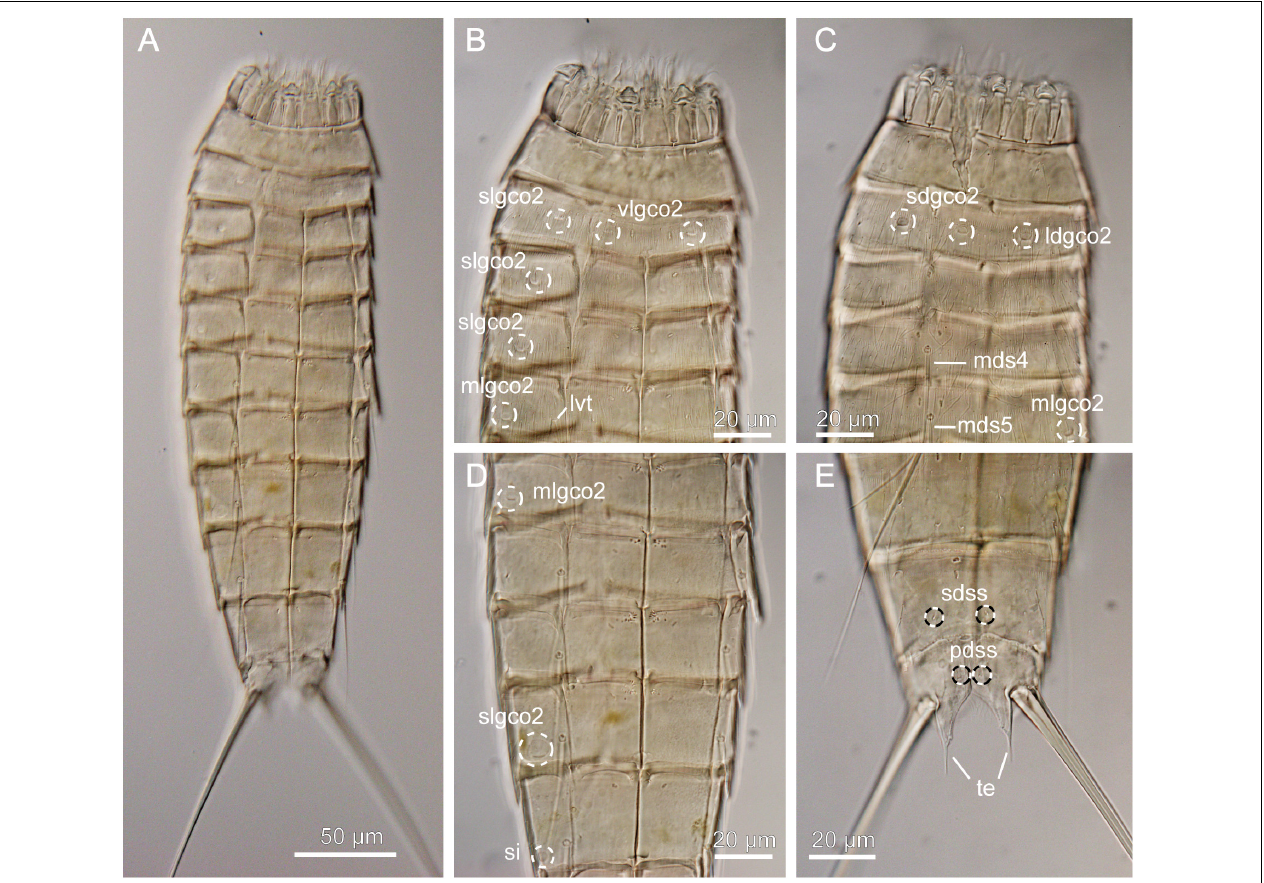
FIGURE 5 | Light micrographs showing overview and details of female Echinoderes juliae (NHMD-872652) collected at station 1. (A) Ventral overview. (B) Segments 1 to 5, ventral view. (C) Segments 1 to 5, dorsal view. (D) Segments 5 to 9, ventral view. (E) Segments 9 to 11, dorsal view. ldgco2 , glandular cell outlet type 2; lvt , lateroventral tube; mds , middorsal spine, followed by segment number; mlgco2 , glandular cell outlet type 2; pdss , paradorsal sensory spot; sdgco2 , subdorsal glandular cell outlet type 2; sdss , subdorsal sensory spot; si , sieve plate; slgco2 , sublateral glandular cell outlet type 2; te , tergal extension; vlgco2 , ventrolateral glandular cell outlet type